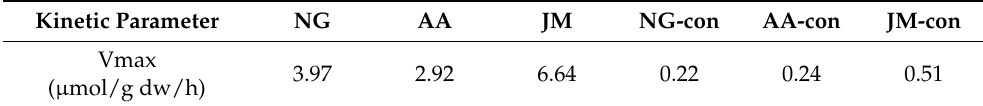
Table 4. Vmax values for columns at depths of 15–25